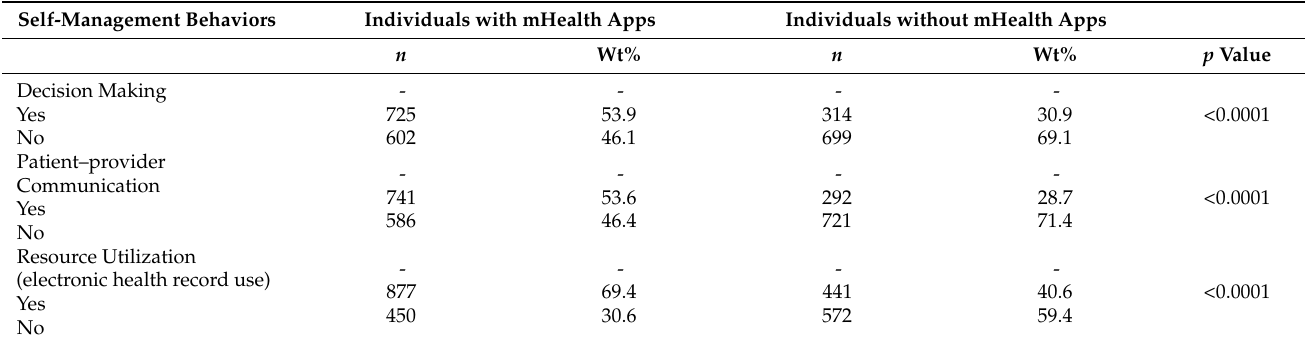
Table 2. Comparisons of Different Self-management Behaviors Between Individuals with and without mHealth Applications. Self-Management Behaviors